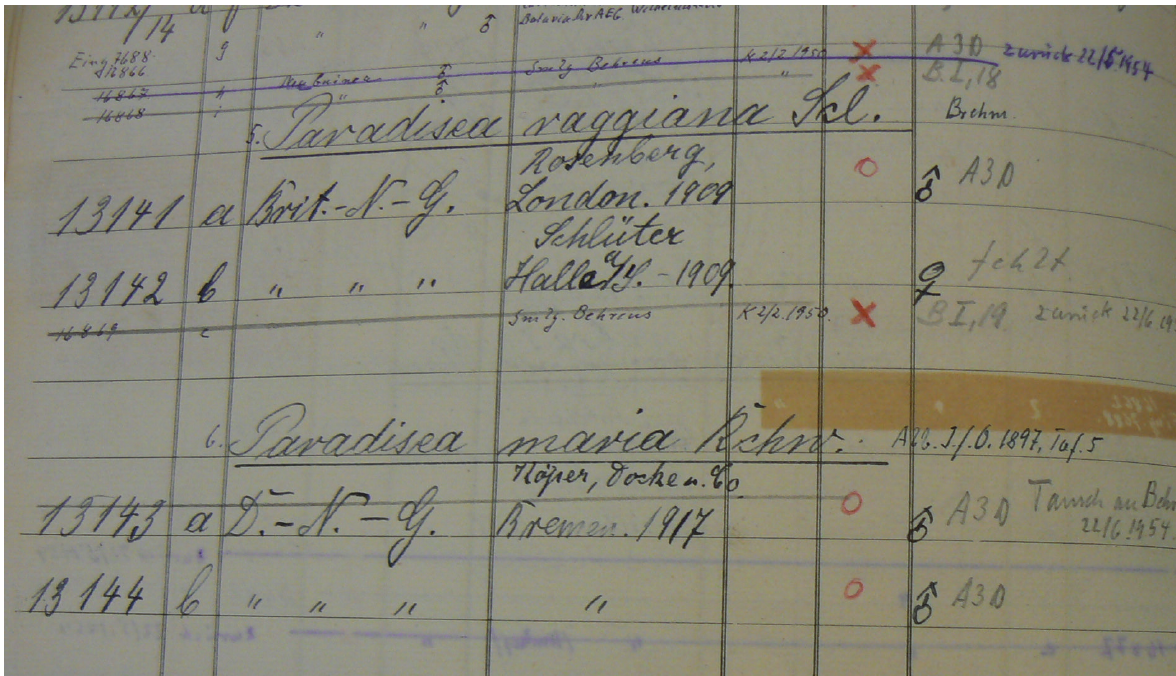
Figure 5. Catalogue page from the Überseemuseum in Bremen with the entries of two specimens of P. maria (catalogue numbers 13143 and 13144), the former of which was, probably among others, exchanged with Walter Behrens on 22 June 1954 and which is now SNMB N49068 at the Braunschweig collection. Both male specimens were transported to Bremen by the trading company Köper, Docke u. Co. in 1917. Photo by M.